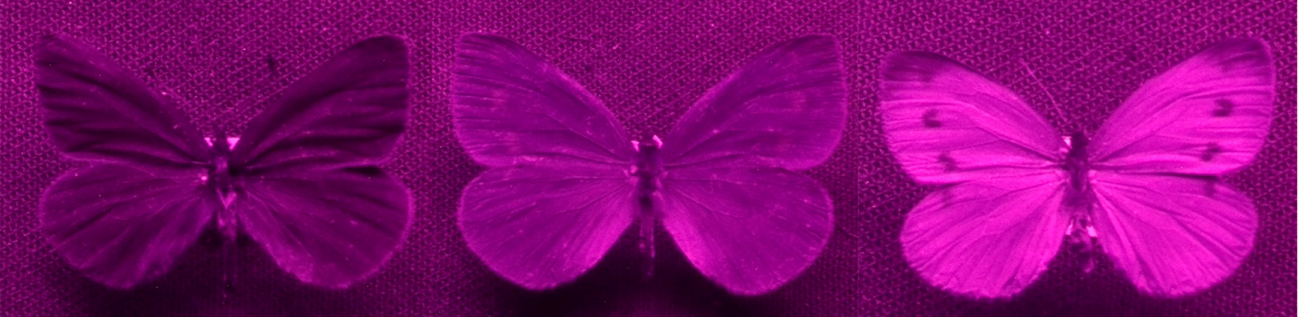
Figure 1. Various specimens of Pieris napi in UV light. The UV component of natural light decreases at higher latitudes due to a lower angle of the sun, which is why UV signals must be stronger to facilitate functional communication. Therefore, different specimens reflect different amounts of UV